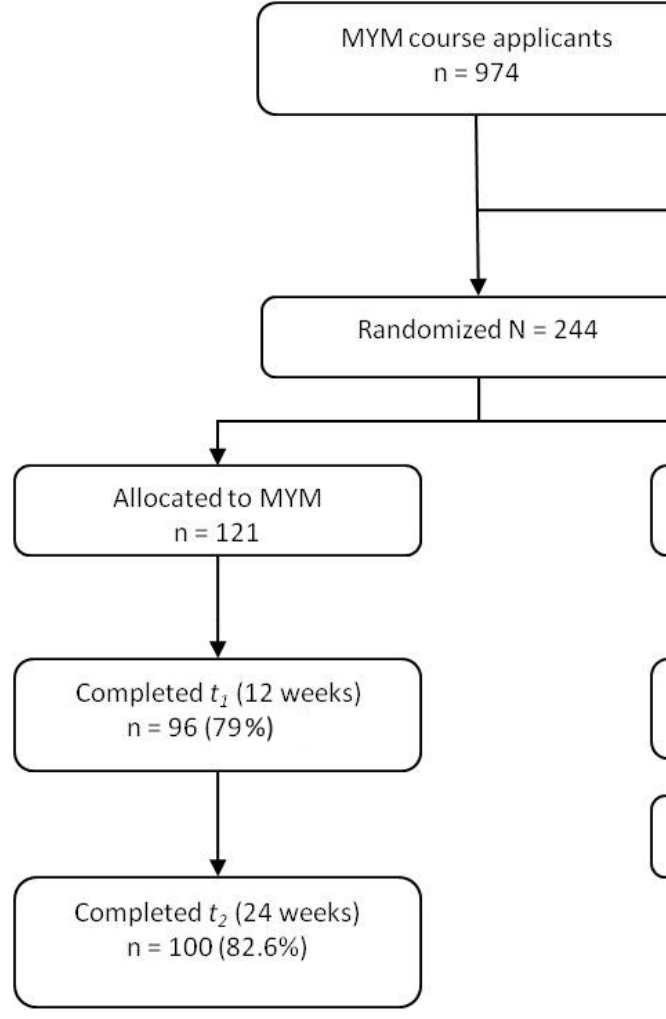
Figure 1. Flow chart of respondent selection. CES-D = Center for Epidemiologic Studies Depression Scale; MINI-Plus: Mini-International Neuropsychiatric Interview; MYM = Master Your